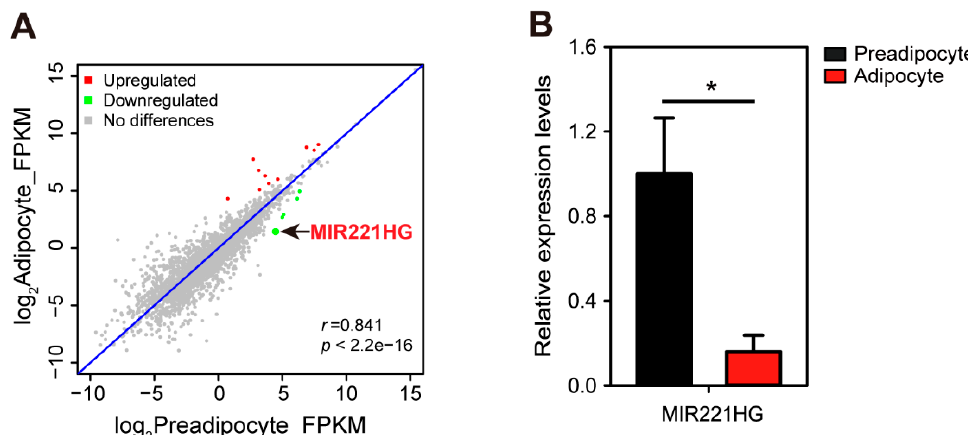
Figure 1. long noncoding RNA miR-221 host gene (MIR221HG) is downregulated in adipocyte di ff erentiation. ( A ) A scatter plot shows the correlation of lncRNA abundance between preadipocytes and adipocytes. The red dots represent the upregulated lncRNAs in adipocytes; the green dots represent the downregulated lncRNAs. ( B ) Validation of lncRNA MIR221HG. Total RNA of preadipocytes and adipocytes were respectively extracted, and qRT-PCR was conducted to verify the di ff erential expression of MIR221HG. The data are presented as mean ± SE from three independent experiments. * p < 0.05.